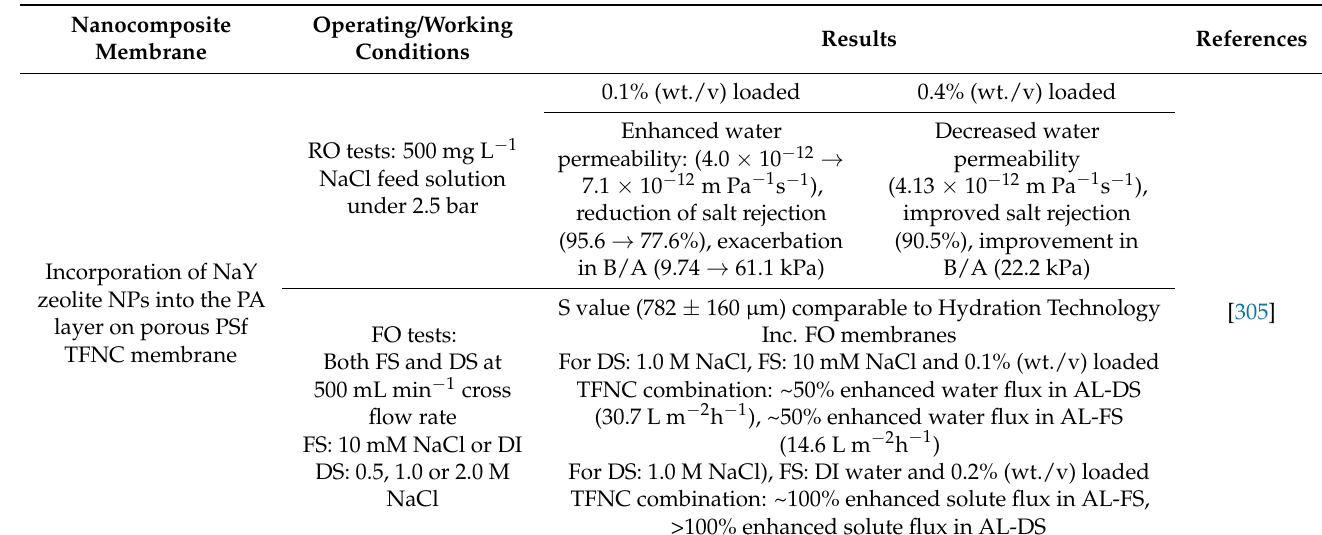
Figure 11. Migration behavior of Cu 2+ on the ZIF–8 framework ( a – c ). Adapted with permission from Li et al. [286]. Copyright (2022) Elsevier. Table 7. Comparison of zeolite-loaded TFNC membranes with pristine membranes under specific